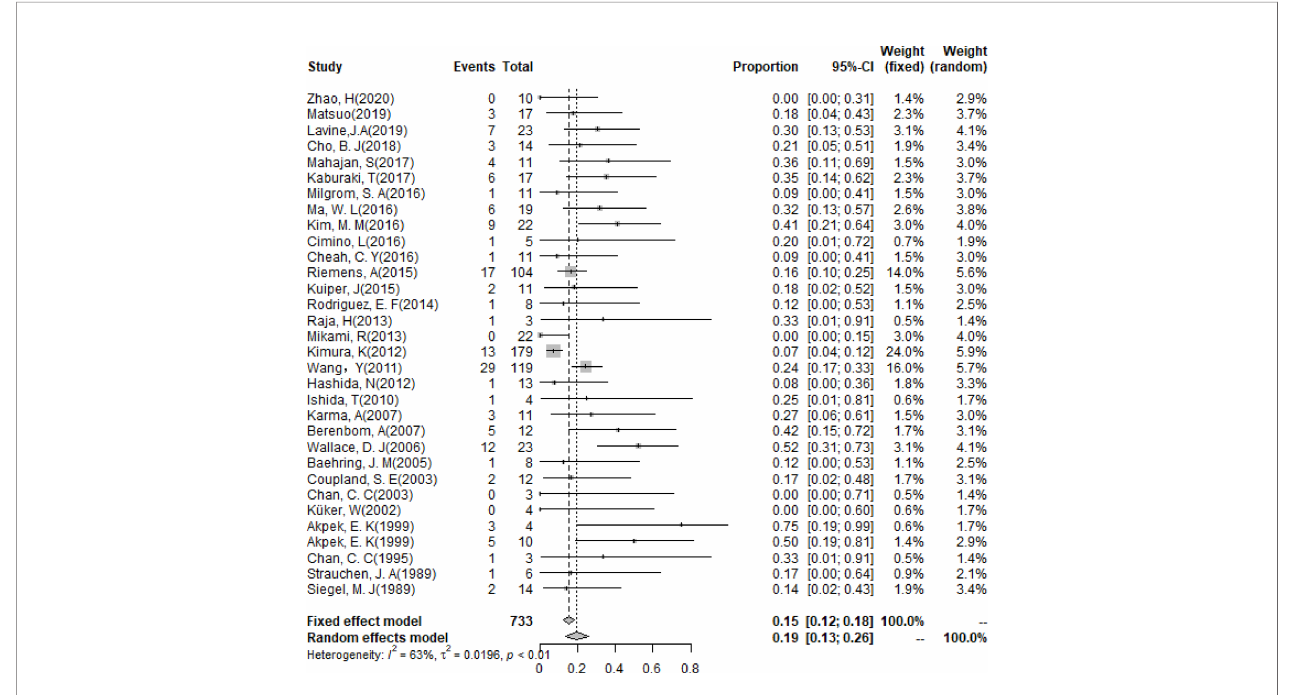
FIGURE 2 | Forest plots of CNS involvement rate at fi rst